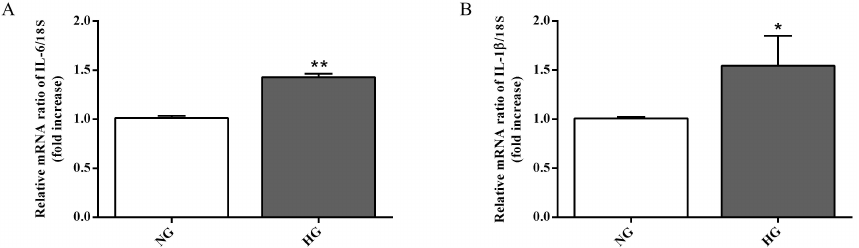
Figure 4. Measurement of ( A ) IL-6 and ( B ) IL-1 β mRNA expression levels (qRT-PCR) in astrocytes subjected to normal or high glucose conditions for 48 h. The abundance of each mRNA of interest was expressed relative to the abundance of 18S rRNA, as an internal control. NG = normal glucose condition (5 mM); HG = high glucose condition (40 mM). Values are means ± SD of three independent experiments. Statistical analysis was performed using Student’s t-test. * p < 0.05 vs. NG; ** p < 0.01 vs. NG.